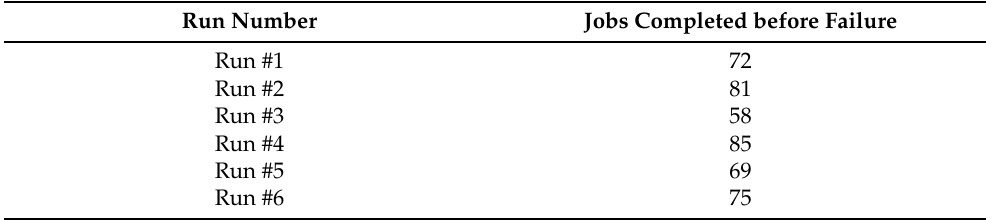
Table 2. Recorded failures of our